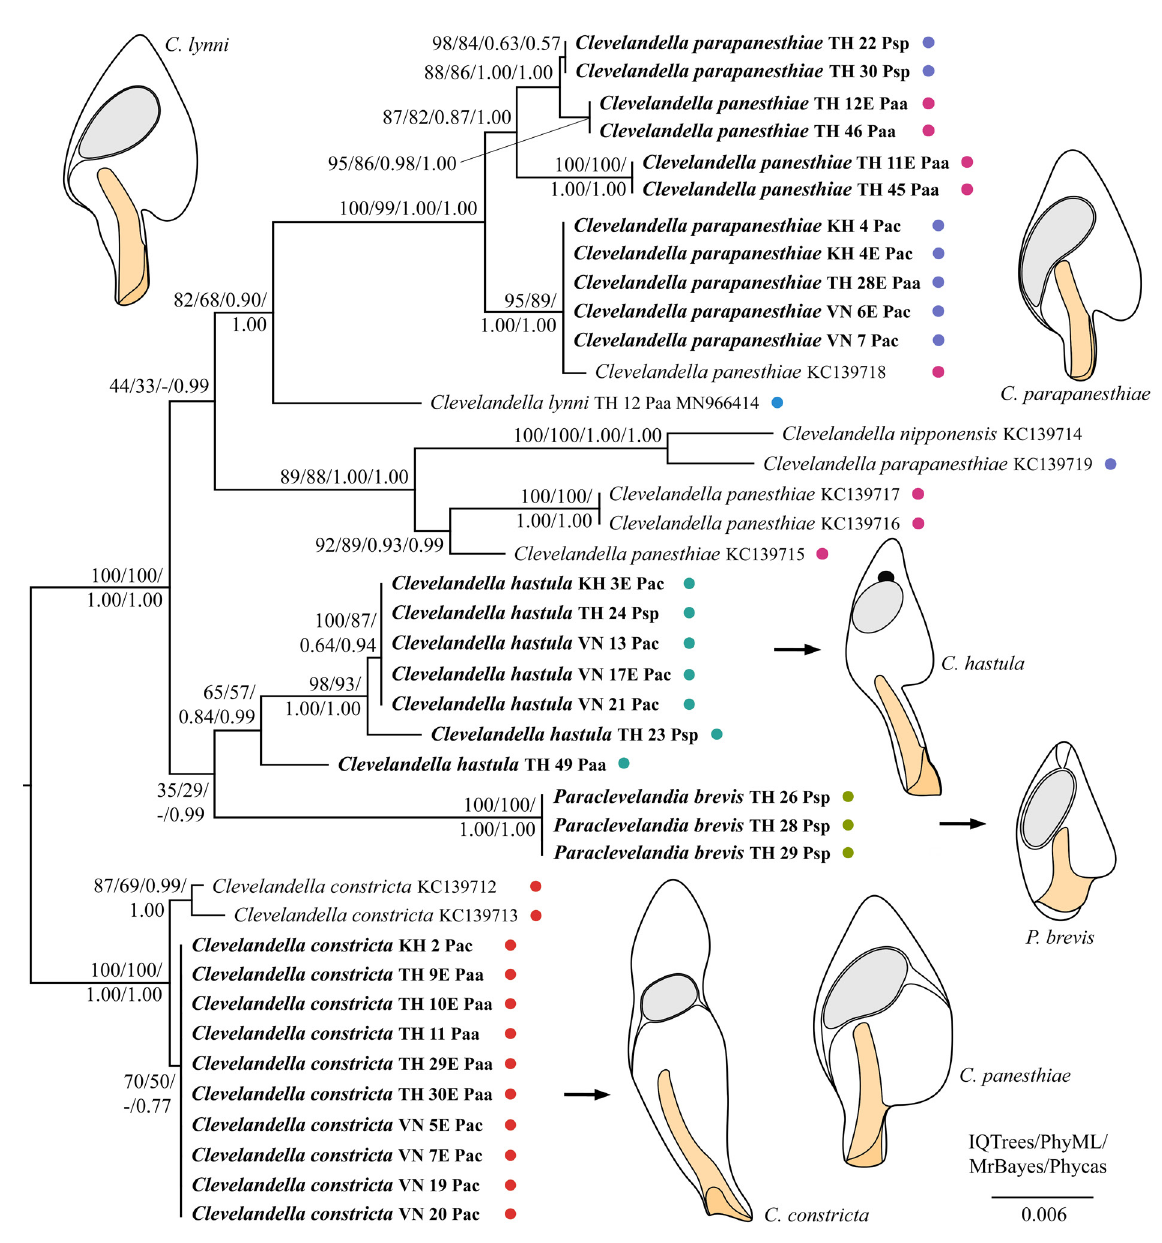
Fig. 18. Phylogeny of the family Clevelandellidae Kidder, 1938 based on 18S rRNA gene sequences. Bootstrap values for maximum likelihood analyses performed in IQTrees and PhyML as well as posterior probabilities for Bayesian interference performed in MrBayes and Phycas were mapped onto the best scoring IQTree. Dashes indicate statistical support below 50%. Sequences obtained in this study are in bold face. Members of each morphospecies are marked by the same color, as shown in Fig. 17. For specimen codes and further details, see Table 6. The scale bar denotes six substitutions per one thousand nucleotide